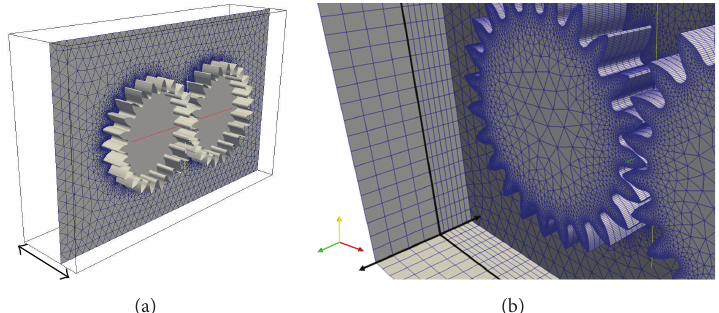
Figure 1: Discretization of the internal planar faces: this mesh will then be extruded in both